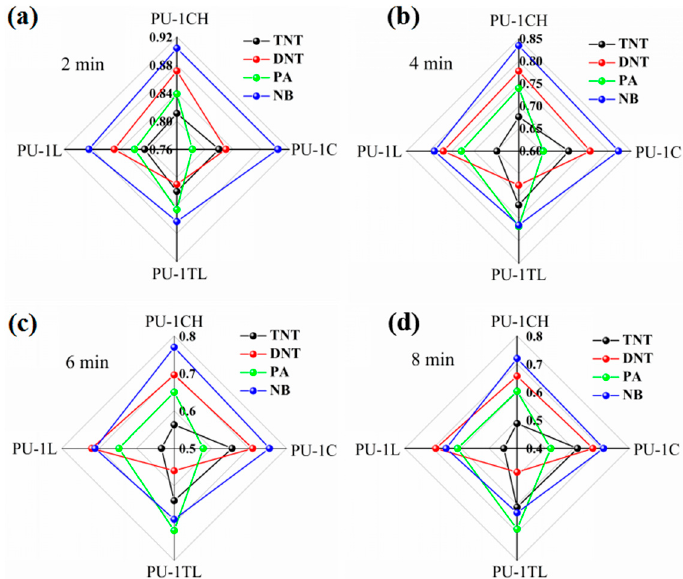
Figure 6. Fingerprints of three nitroaromatic explosives according to the quenching percentage of the sensing array based on fluorescent membranes as a function of time ( a ) 2 min, ( b ) 4 min, ( c ) 6 min, ( d ) 8 min.